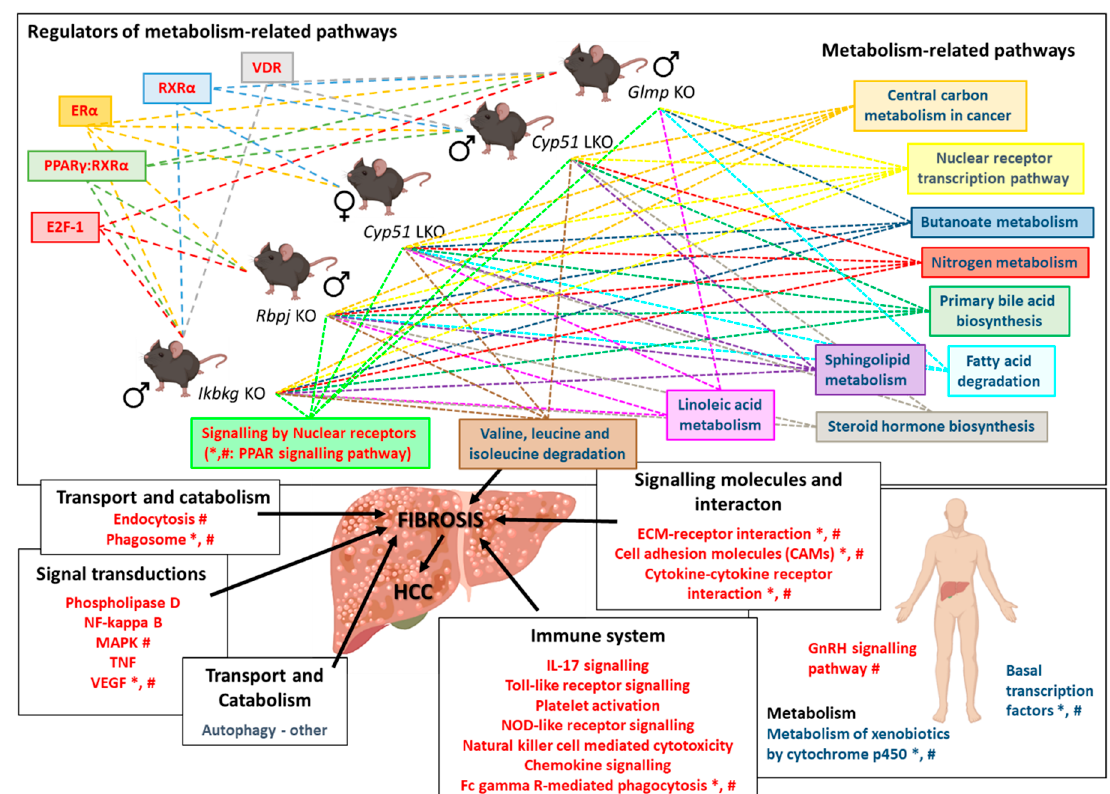
Figure 5. Scheme of the common transcriptional program in mouse liver fibrotic models. Knocking out a single gene from different unrelated pathways ( Cyp51 , Rbpj , Ikbkg, and Glmp ) leads to downregulation of metabolism-related pathways, regulated by different TFs, and upregulation of signaling pathways, resulting in fibrosis. Mouse transcriptome data from mouse models was compared to human NAFLD and NASH transcriptome data [18]. *—pathways/TFs enriched also in human NAFLD; # —pathways/TFs enriched in human NASH. Blue text color—negatively enriched KEGG/Reactome/TFs; Red text color—positively enriched KEGG/Reactome/TFs. Dashed arrows indicate enriched pathways/TFs in individual liver fibrotic mouse model. Icons are used from the BioRender library.